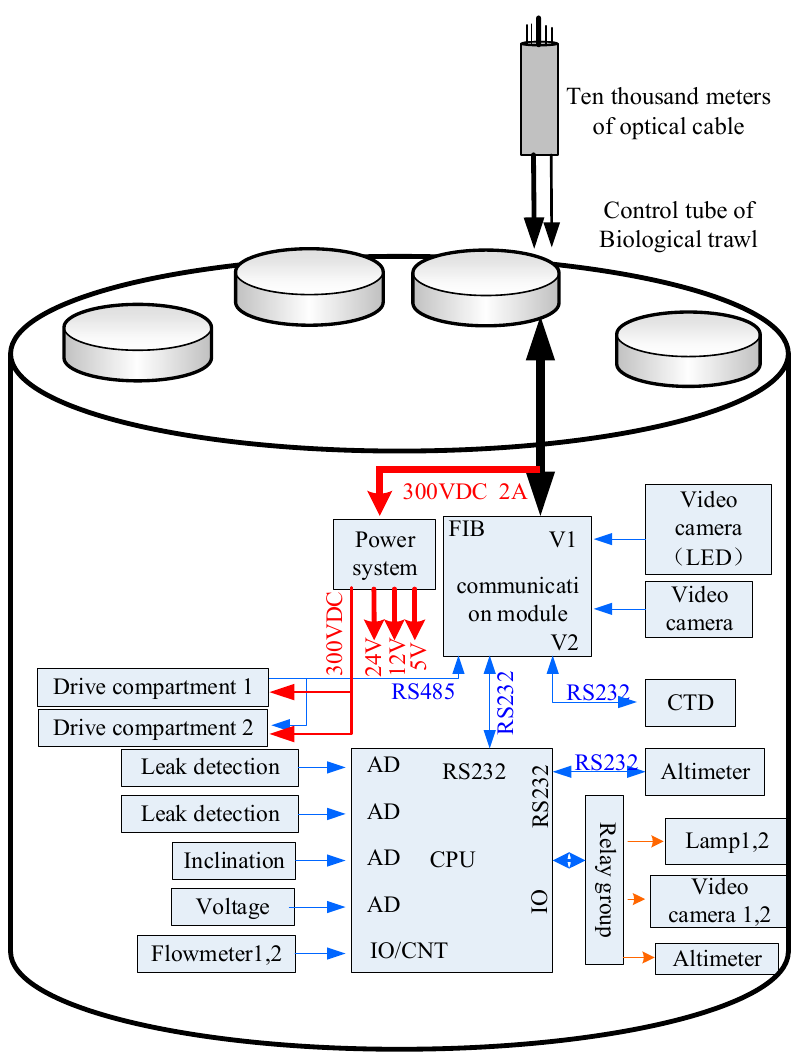
Figure 10. Block diagram of the main control